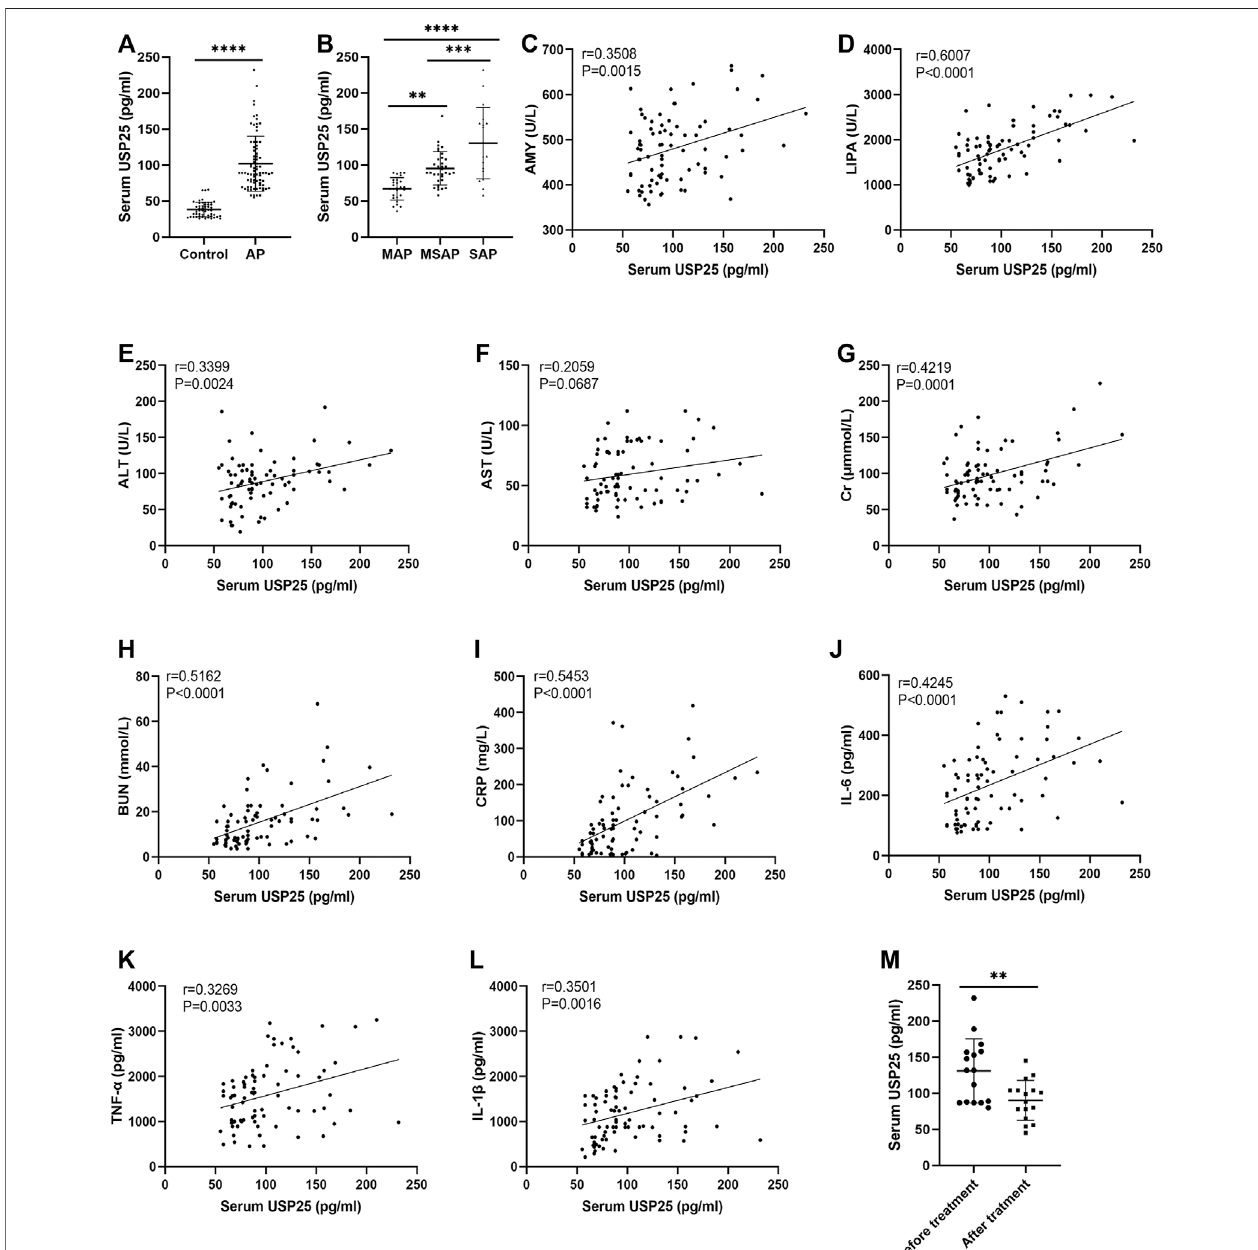
FIGURE 1 | Serum USP25 concentrations is higher in patients with acute pancreatitis and positively correlated with the disease severity and multiple organ injury. (A) USP25 expression in serum samples from healthy controls (n (cid:1) 53) and acute pancreatitis (AP) patients (n (cid:1) 79) was detected by ELISA. (B) Serum USP25 concentrationsinMAP(n (cid:1) 27), MSAP(n (cid:1) 34),and SAP(n (cid:1) 18)patients werecompared. (C – L) TherelationshipbetweenserumUSP25andAMY, LIPA,ALT, AST,Cr, BUN, CRP, IL-6, TNF- α , and IL-1 β (n (cid:1) 79) were analyzed. (M) Serum USP25 concentrations of AP patients (n (cid:1) 16) before and after treatment were compared. ** p < 0.01, *** p < 0.001 and **** p < 0.0001 compared with control groups.